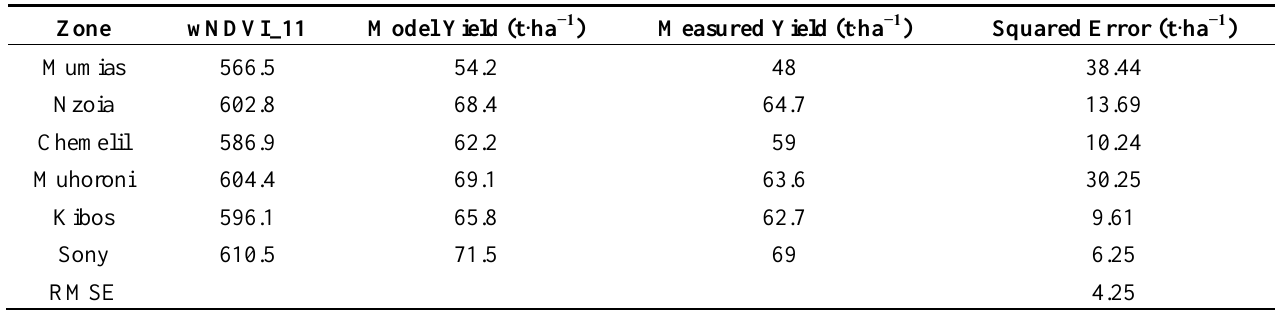
Table 2. Model validation using 2012